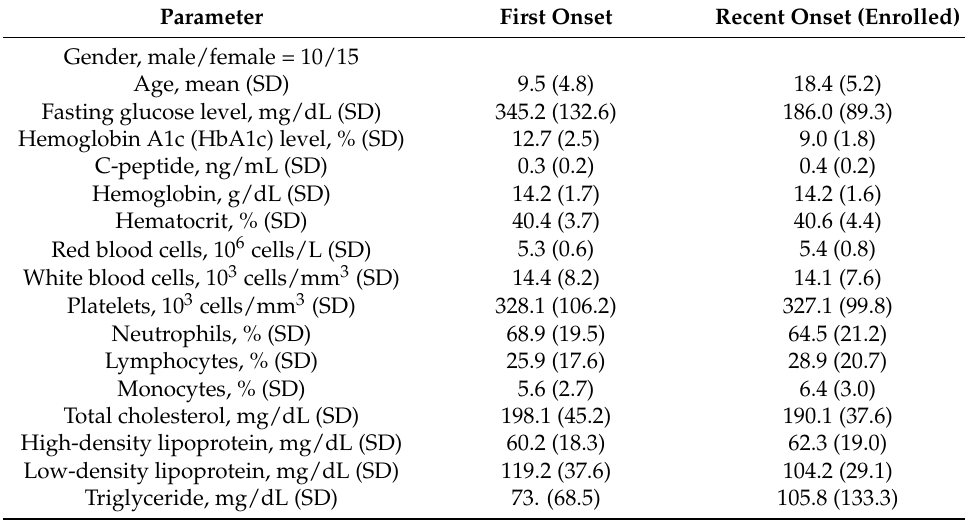
Table 1. Clinical characterization of T1DM patients ( n =